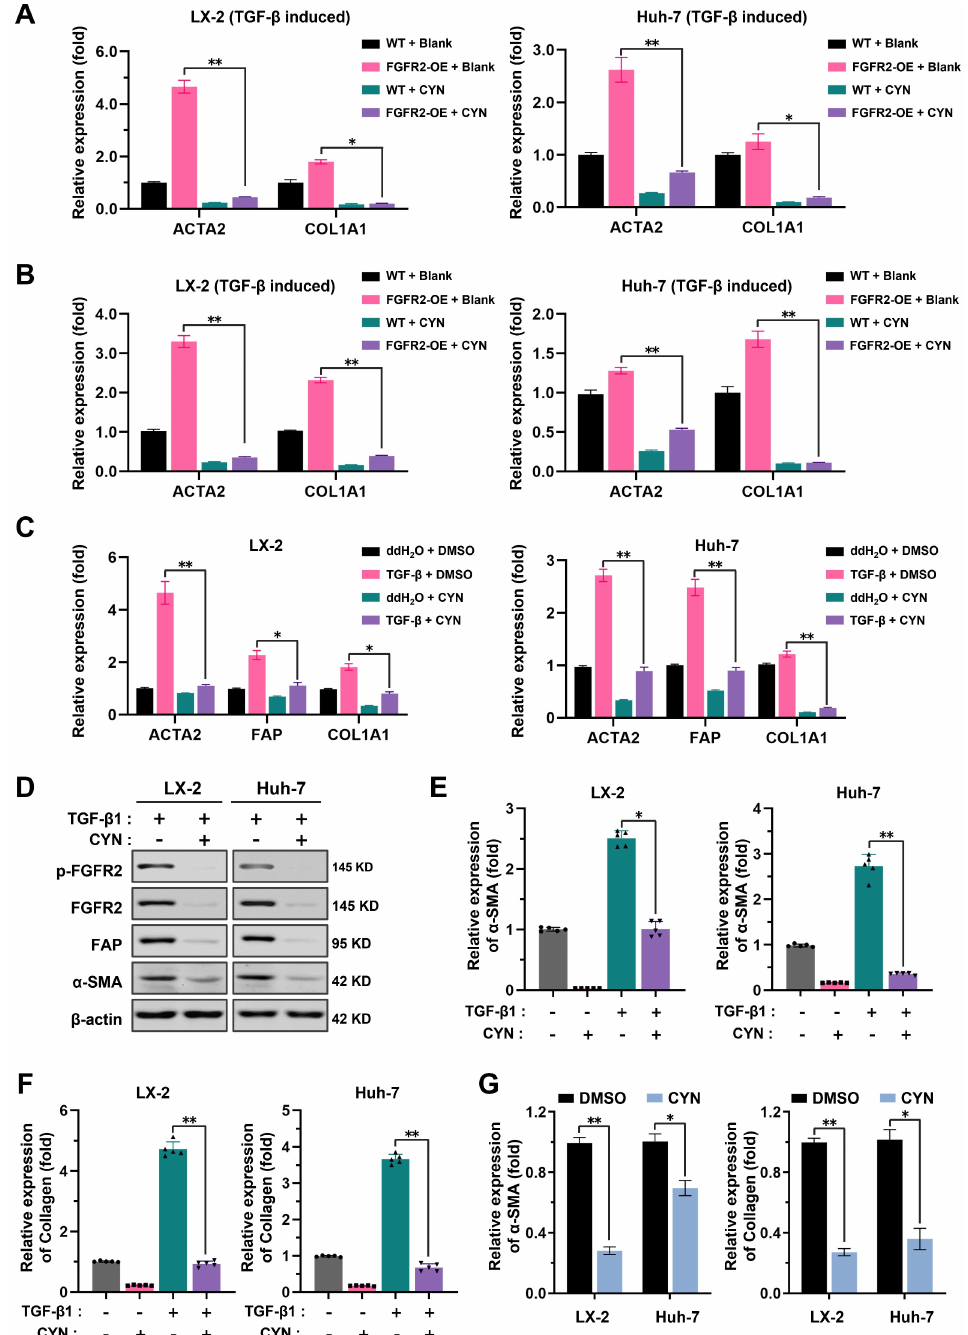
Figure 4. CYN blocks the activation and development of liver fibrosis in vitro. ( A ) Evaluation of the inhibitory effect of CYN on the fibrosis-promoting effect of FGFR2. The fibrotic